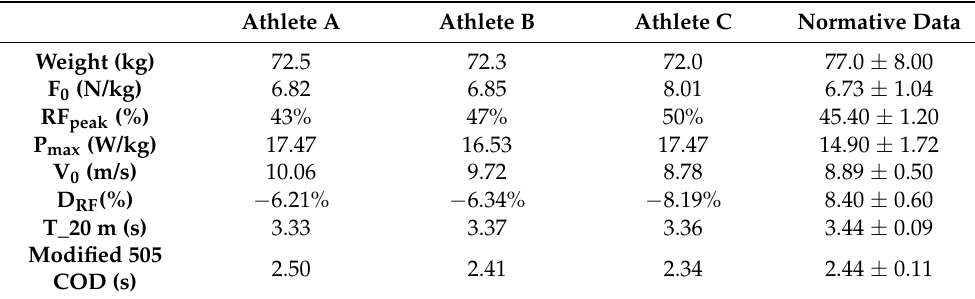
Table 1. Descriptive data of the sprint FV profile mechanical variables and performance in COD and sprint tasks from three different soccer athletes with respect to normative data of medium-level soccer players reported by Jim é nez-Reyes et al. [19] and Haugen et al. [20]. Athlete A